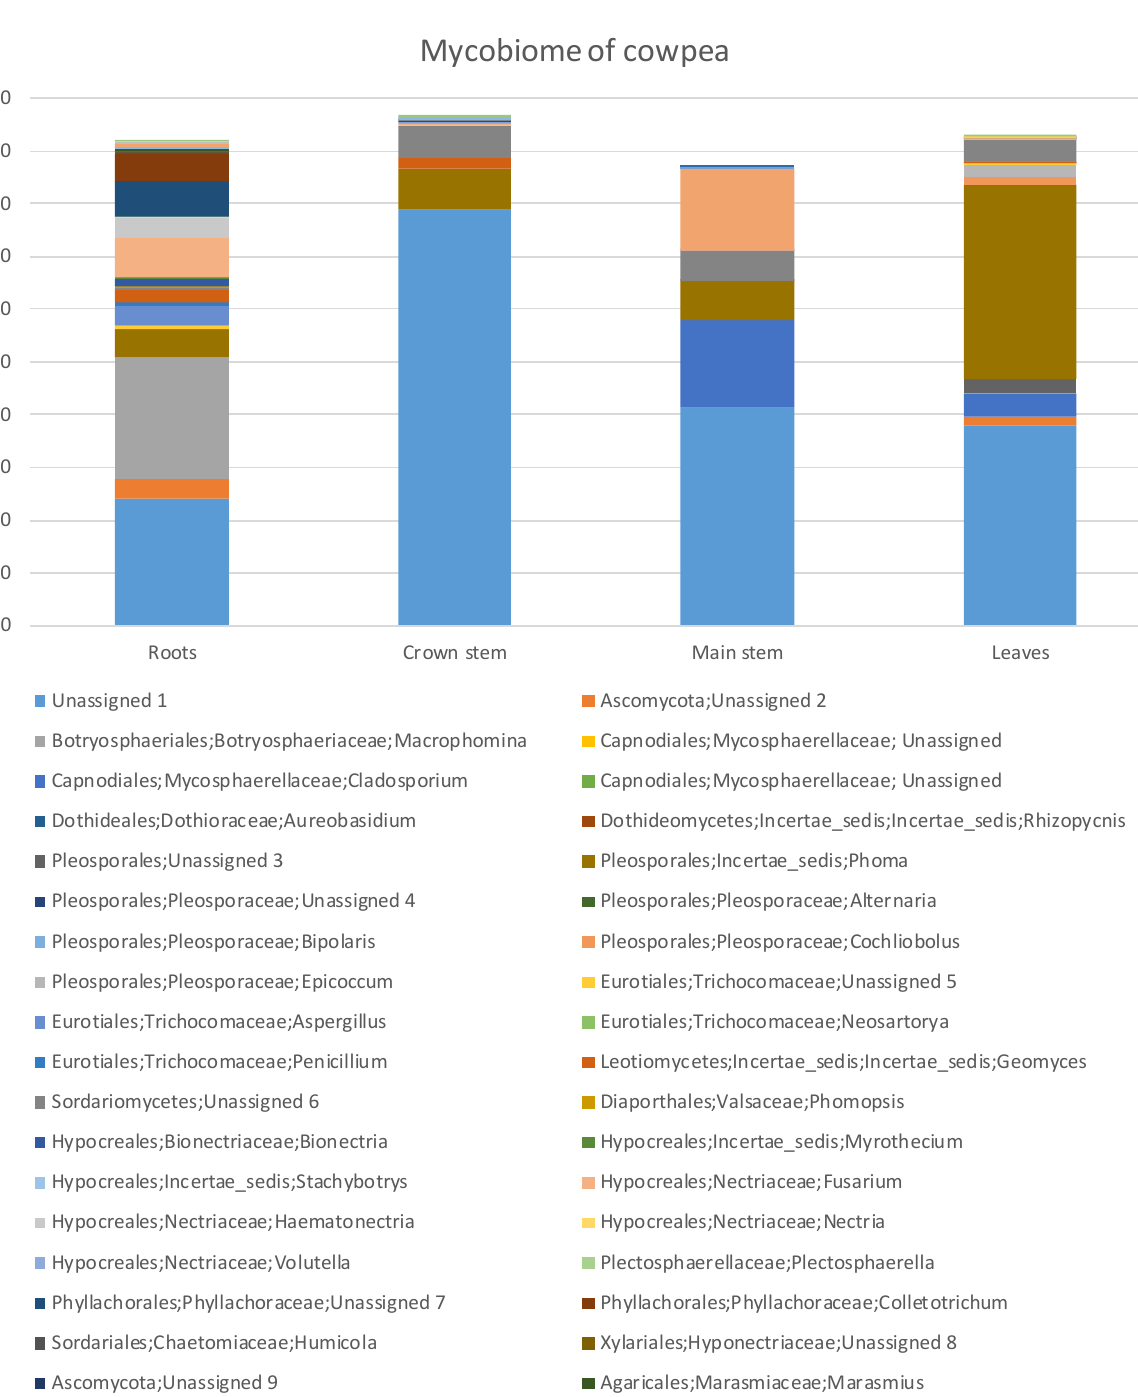
Figure 1. Percentage fungal relative abundance of Molecular Operational Taxonomic Units (MOTUs) up to genus level from roots, crown and main stem and leaves of cowpea at 99% level of sequence